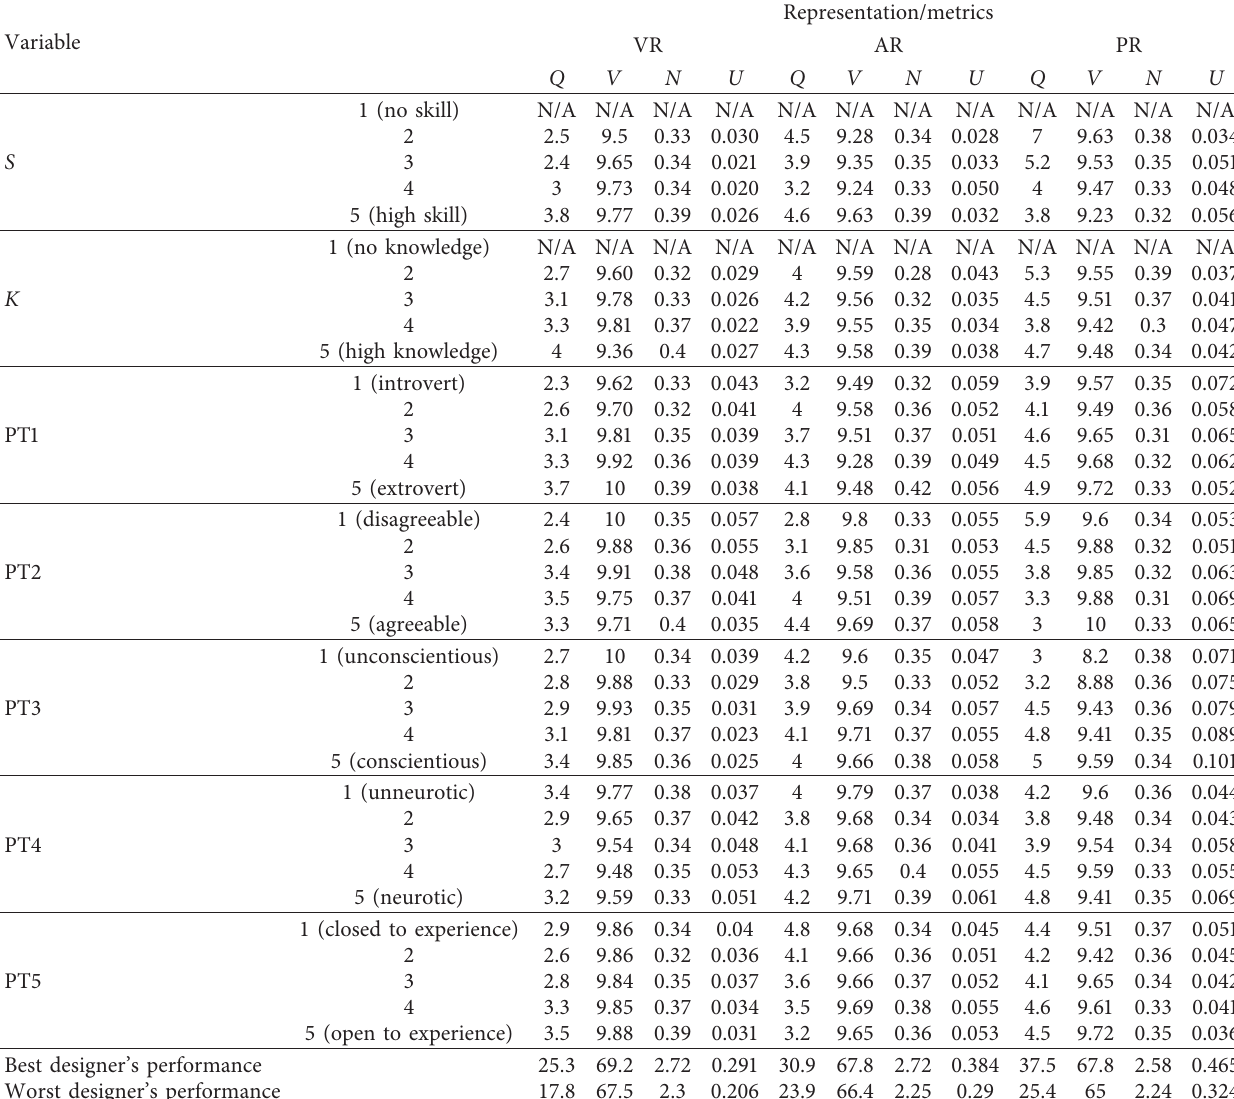
Table 1: DA table related to the shape-based design